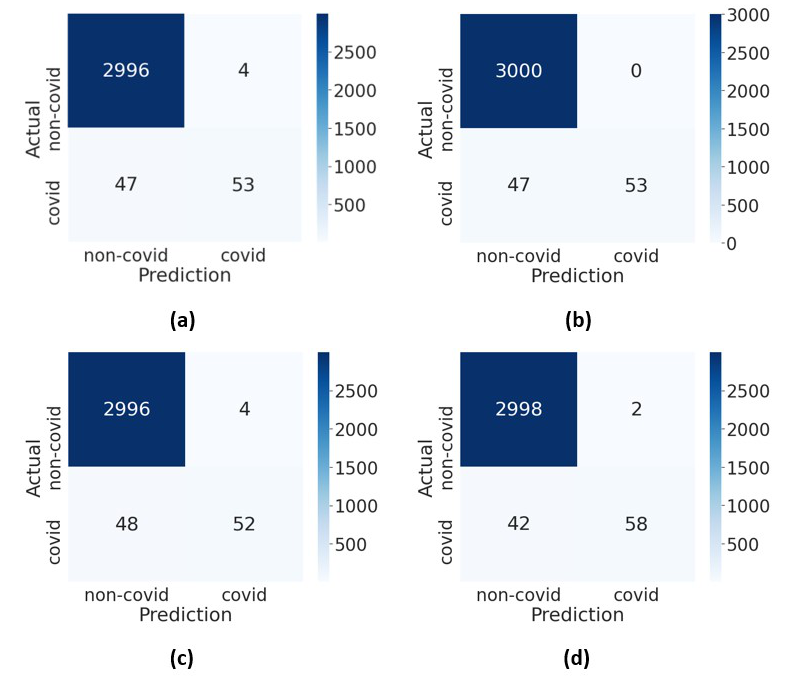
Figure 5. The confusion matrices of the pre-trained models: ( a ) VGG16, ( b ) MobileNetV2, ( c ) ResNet50V2 and ( d ) DenseNet201.